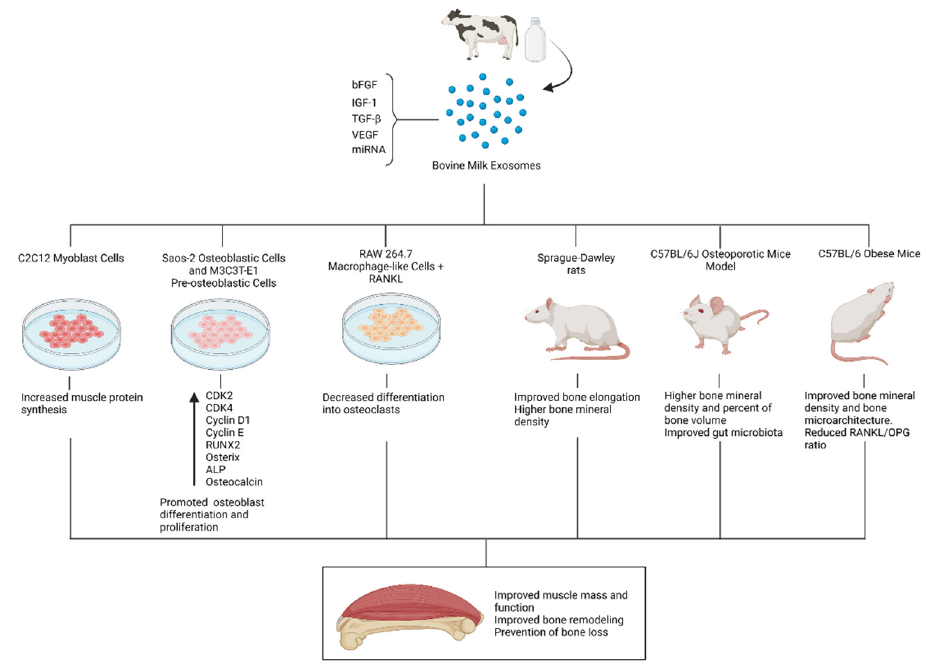
Figure 4. Potential beneficial effects of milk exosomes on the musculoskeletal system.